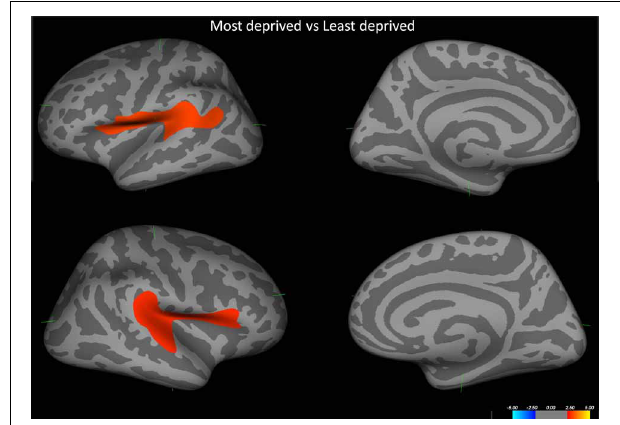
all values of the correlation threshold. Affluent: Least deprived; Deprived: Most deprived.